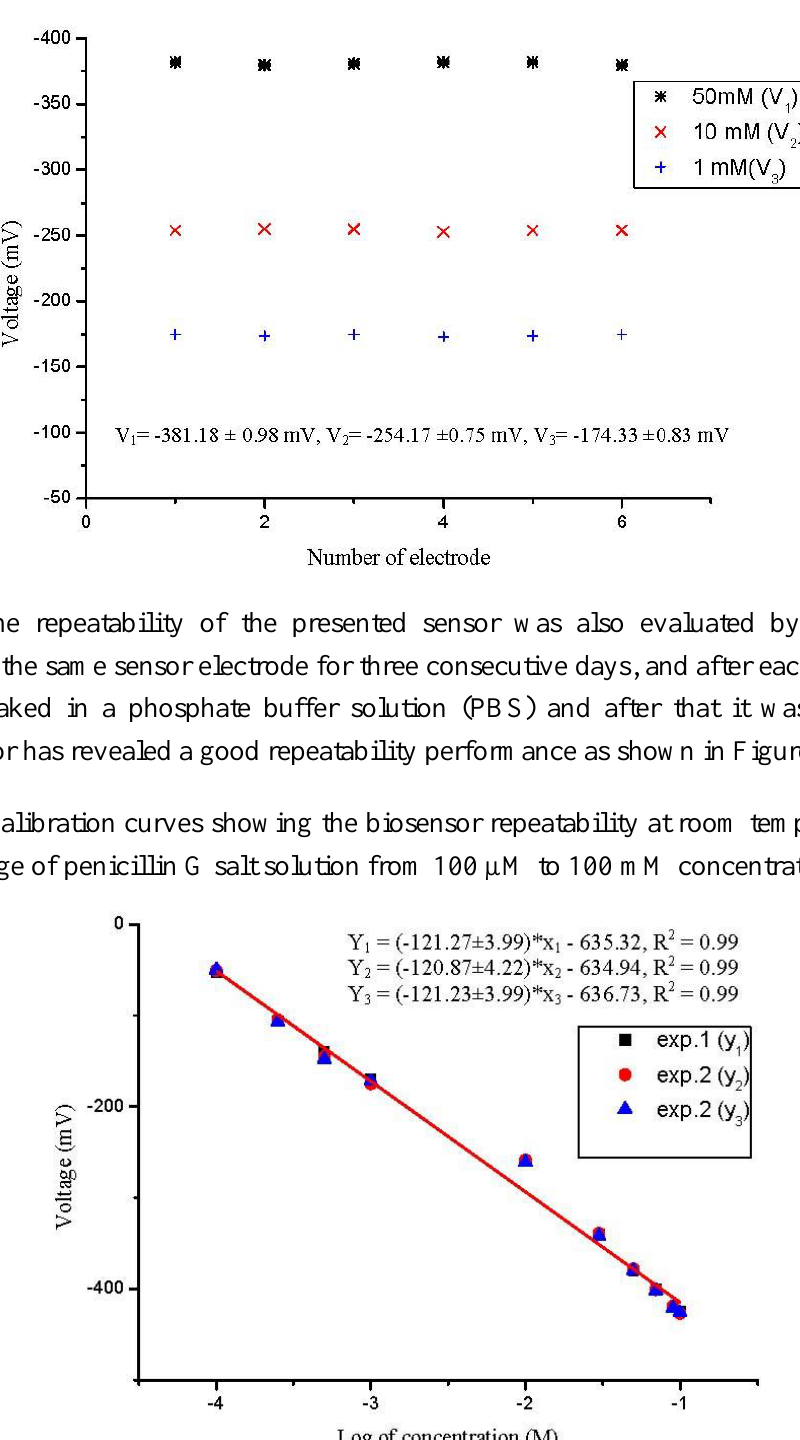
Figure 3. Showing the sensor to sensor reproducibility in 10 mM penicillin solution.